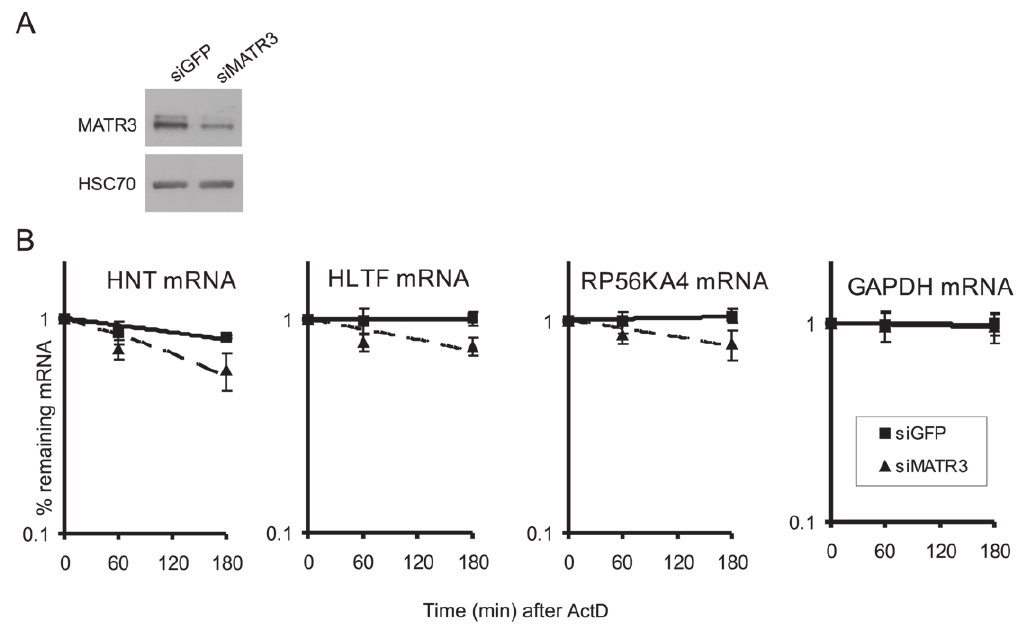
Figure 5. MATR3 stabilizes mRNAs. ( A ) Western blotting of total cellular extracts showing the extent of MATR3 knockdown in U2OS cells 96 hr after transfection with siGFP or siMATR3. ( B ) mRNA half-life was estimated by treating siGFP cells and siMATR3 cells with actinomycin D (2 m g/ml) for the indicated time periods. HLTF, RP56KA4, HNT and GAPDH mRNA levels were measured using qPCR, normalized against 18S rRNA levels and plotted on a scale. The plot represents the mean of three independent experiments and error bars represent